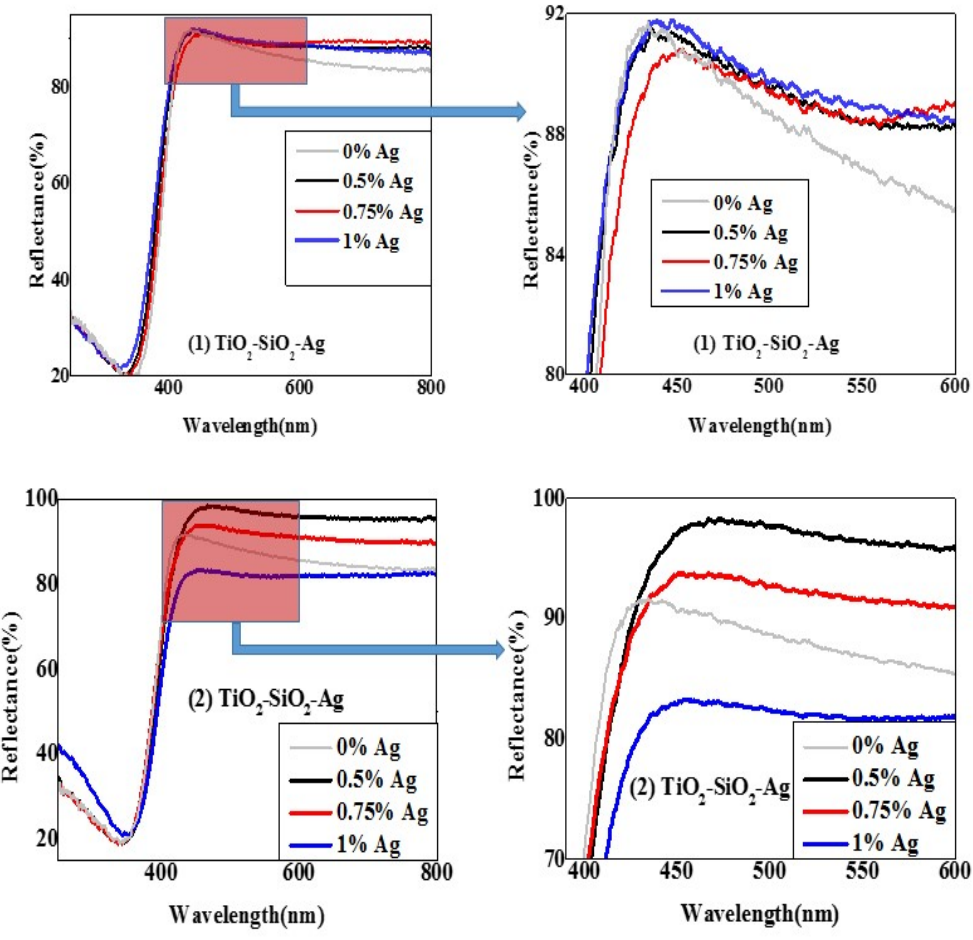
Figure 3. Comparison of different diffuse reflectance spectroscopy (DRS) spectra of the TiO2-SiO2-Ag composites containing differently shaped Au